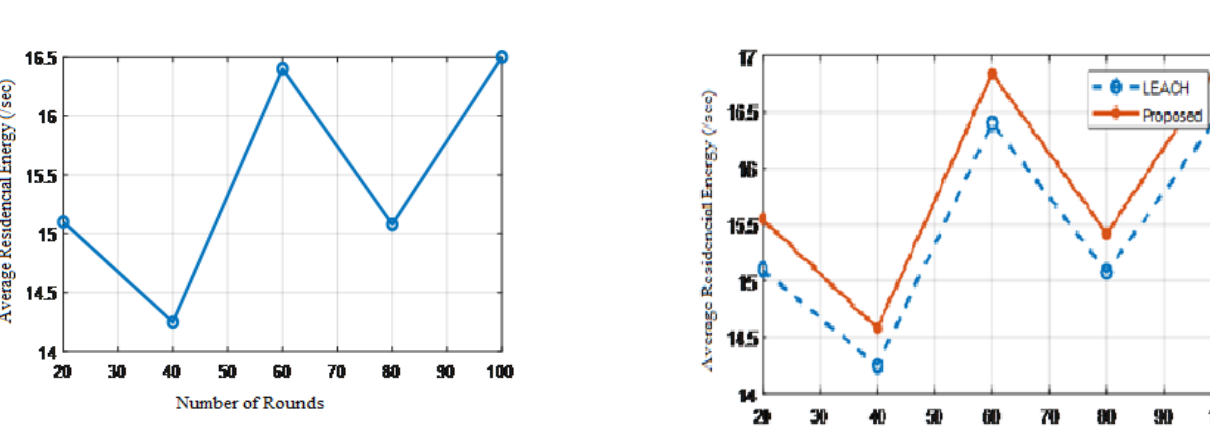
Figure 7. Number of Rounds Vs Average Residual Energy for the proposed protocol